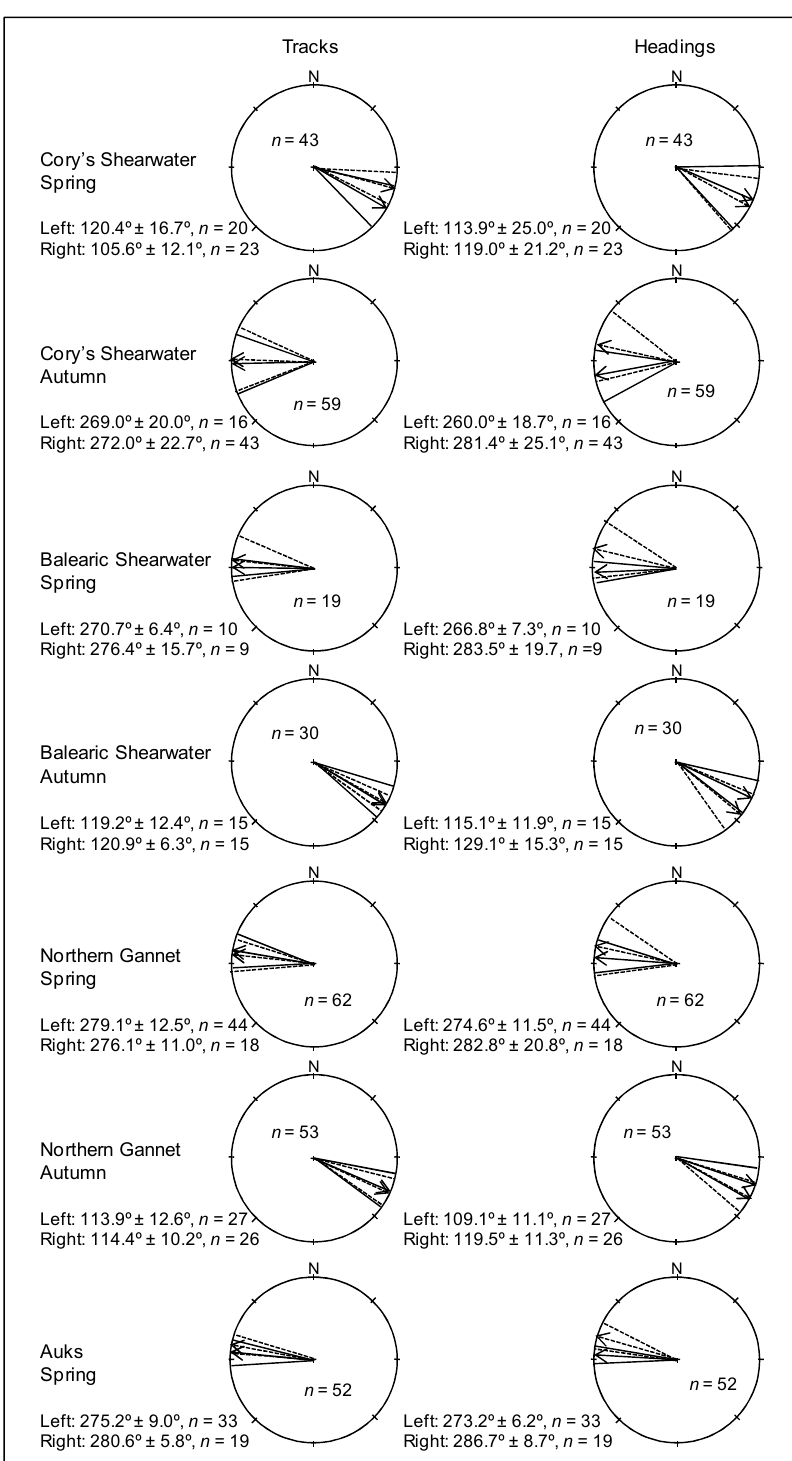
Left: 275.2º ± 9.0º, n = 33 Left: 273.2º ± 6.2º, n = 33 Right: 280.6º ± 5.8º, n = 19 Right: 286.7º ± 8.7º, n = 19 Figure 3. Average track and headings directions, in winds from the left (unbroken bold arrows) and right (broken bold arrows) of the mean direction of each migratory movement. Angular deviations are shown with unbroken lines for flight directions in winds from the left and broken lines for flight directions in winds from the right. n -values given are the total sample sizes and the combined values for both groups together. Mean directions ± angular deviations for each group are given below each panel.